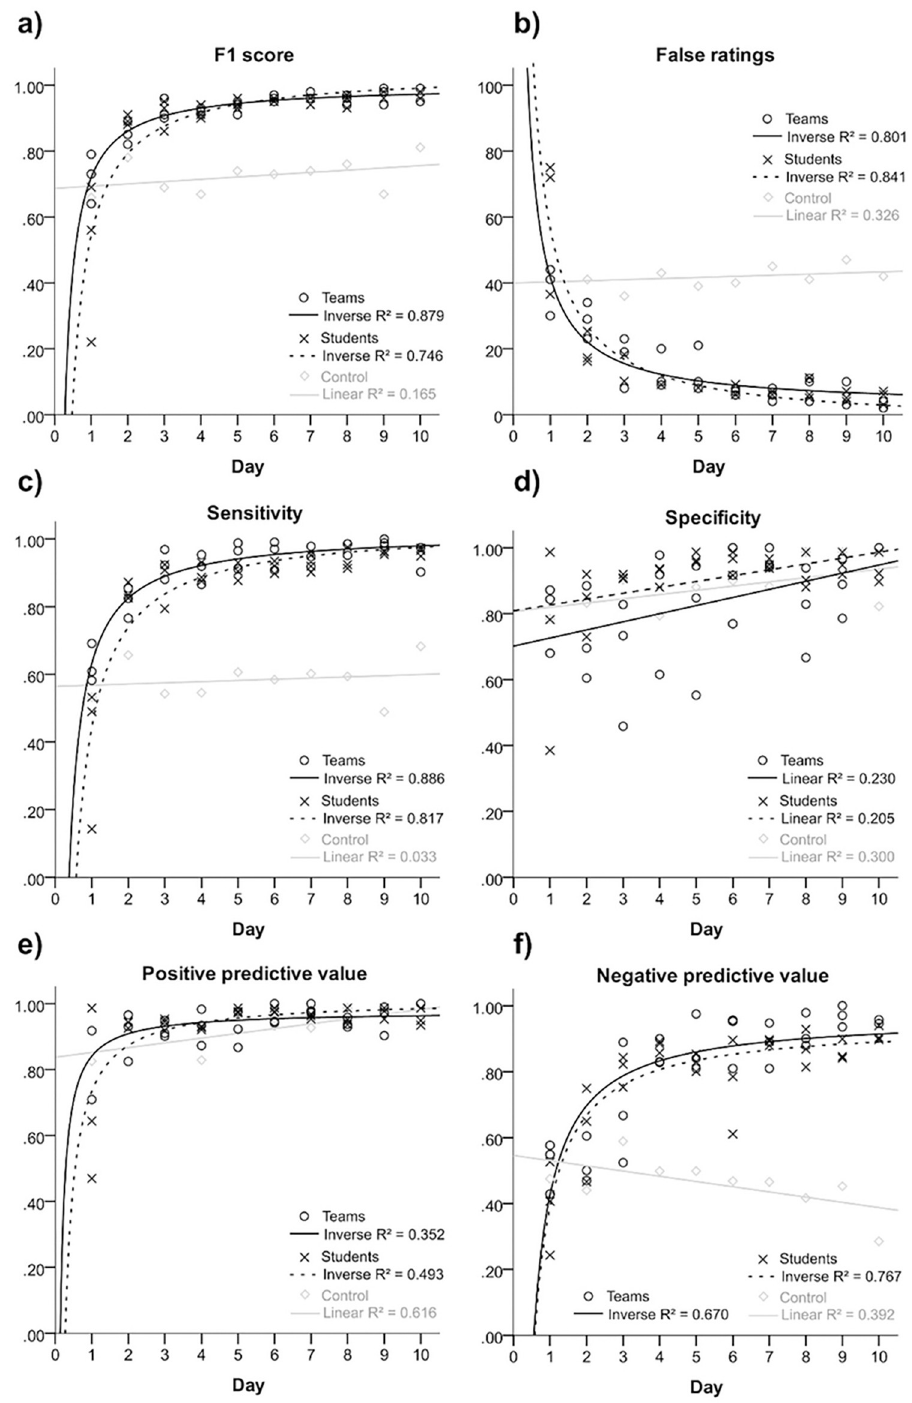
Fig 1. Inverse exponential curves fitted within the regression analyses of the main parameters of interest. For the control, a linear fitting was applied as baseline. R 2 values are given for the three groups: teams (circles), individual raters (crosses), and control